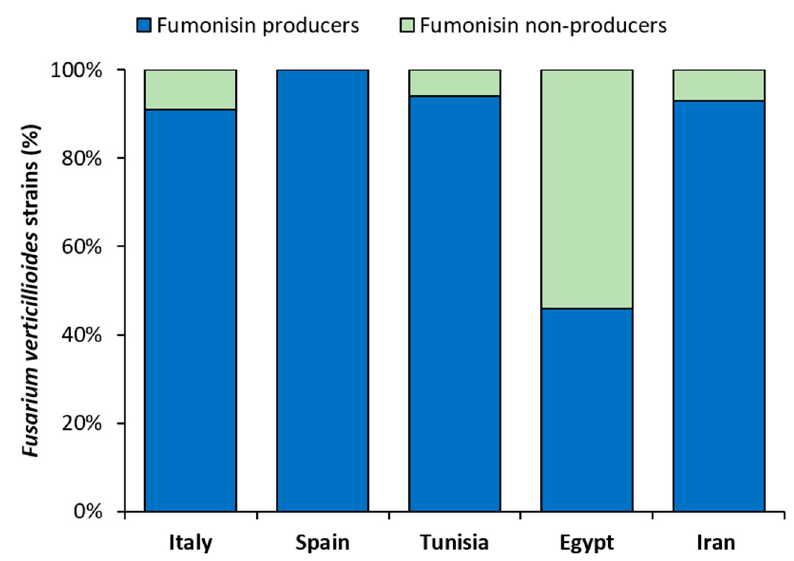
Figure 2. Fusarium verticillioides strains (%) isolated from maize kernels harvested in five Mediterranean countries that showed in vitro production of detectable (fumonisin producers) and non-detectable levels (fumonisin non-producers) of total fumonisins. Italy, n = 22; Spain, n = 9; Tunisia, n = 16; Egypt, n = 28; Iran, n = 15.